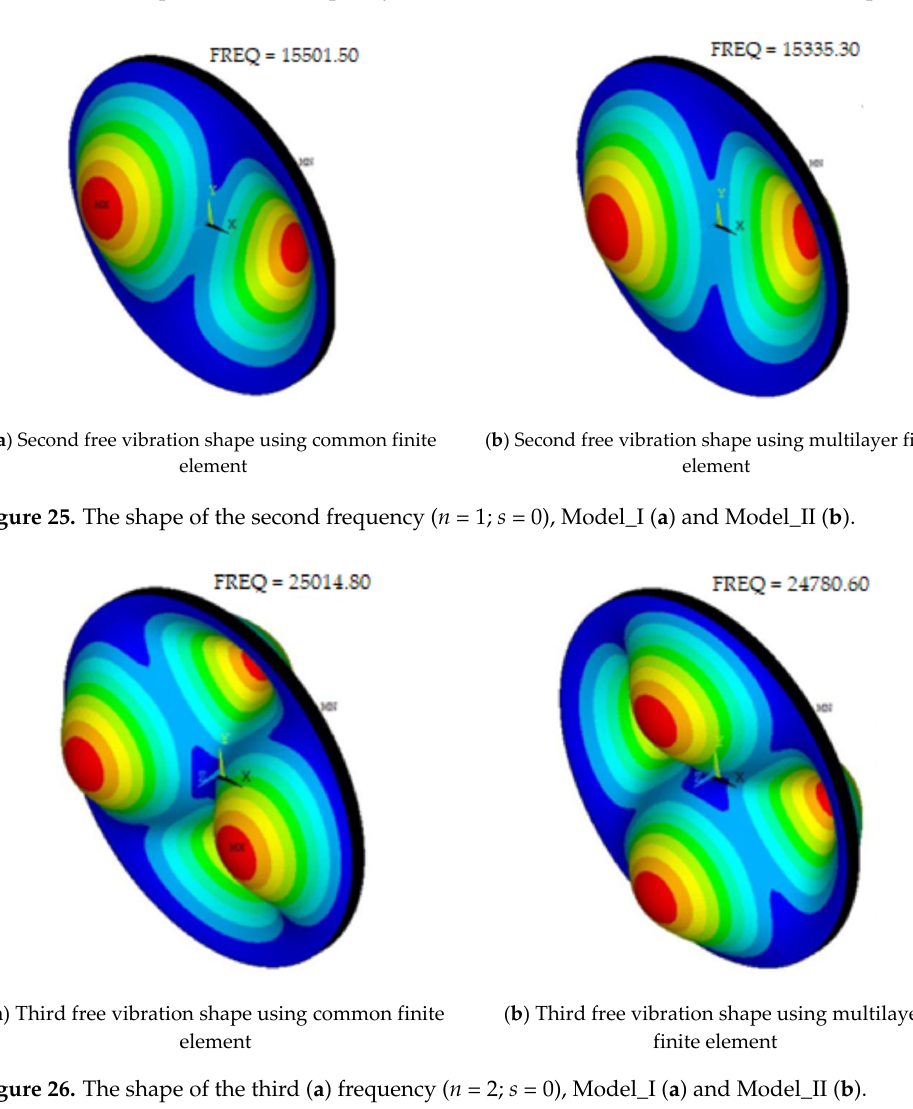
Figure 24. The shape of the first frequency ( n = 0; s = 0), Model_I ( a ) and Model_II ( b )) frequency.